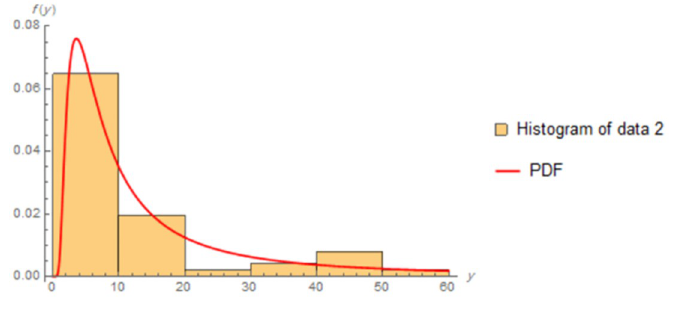
Fig 11. Estimated PDF of data 2.